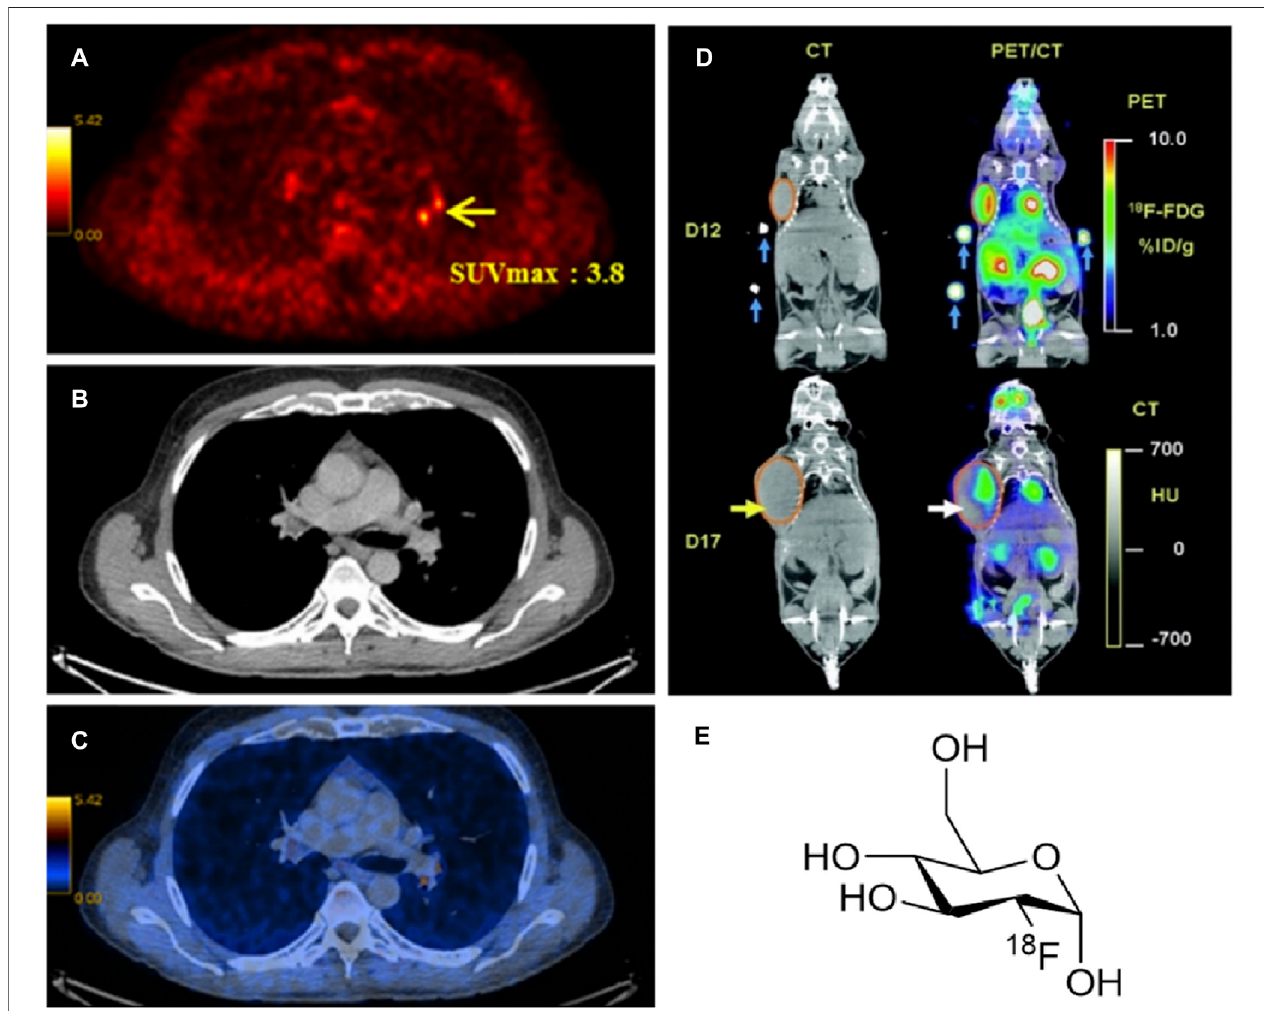
FIGURE 2 |(A) PET image, (B) CT image and (C) PET/CT images ofa male body with prostate cancer (Vali et al., 2015) (SUV: standardised uptake value (Kinahan and Fletcher, 2010) of 18 F- fl uorocholine). (D) Comparison between CT and PET/CT scans for the uptake of [ 18 F]-FDG at day 12 and day 17. (Figure adapted from reference (Berger, 2003)), and (E) the structure of [ 18 F]-FDG